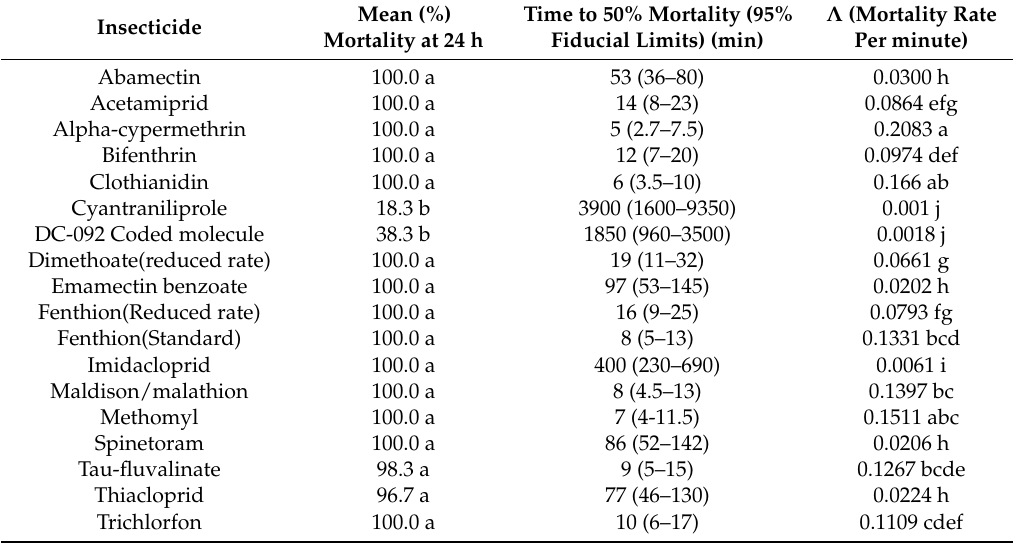
Table 3. The mean percentage mortality at 24 h, time to reach 50% mortality, and the instantaneous mortality rate ( λ ) of adult Bactrocera tryoni exposed to a topical application of insecticide (bioassay 1). Weibull’s shape parameter α =